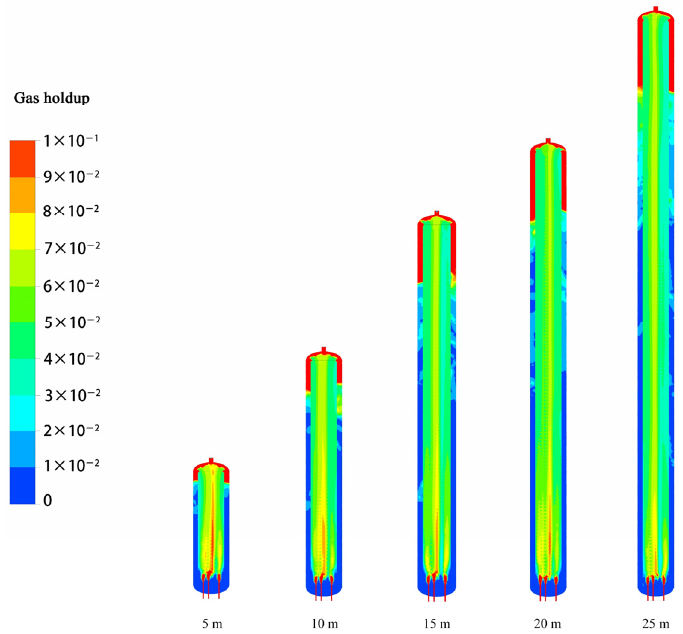
Figure 5. Gas holdup distribution at different total column heights with U Gr of 0.0389 m/s. The gas is enriched at the top region of the downcomer, and the bottom region of the II according to Heijnen et al. [22]. The bubble-enriched zone in the downcomer in the